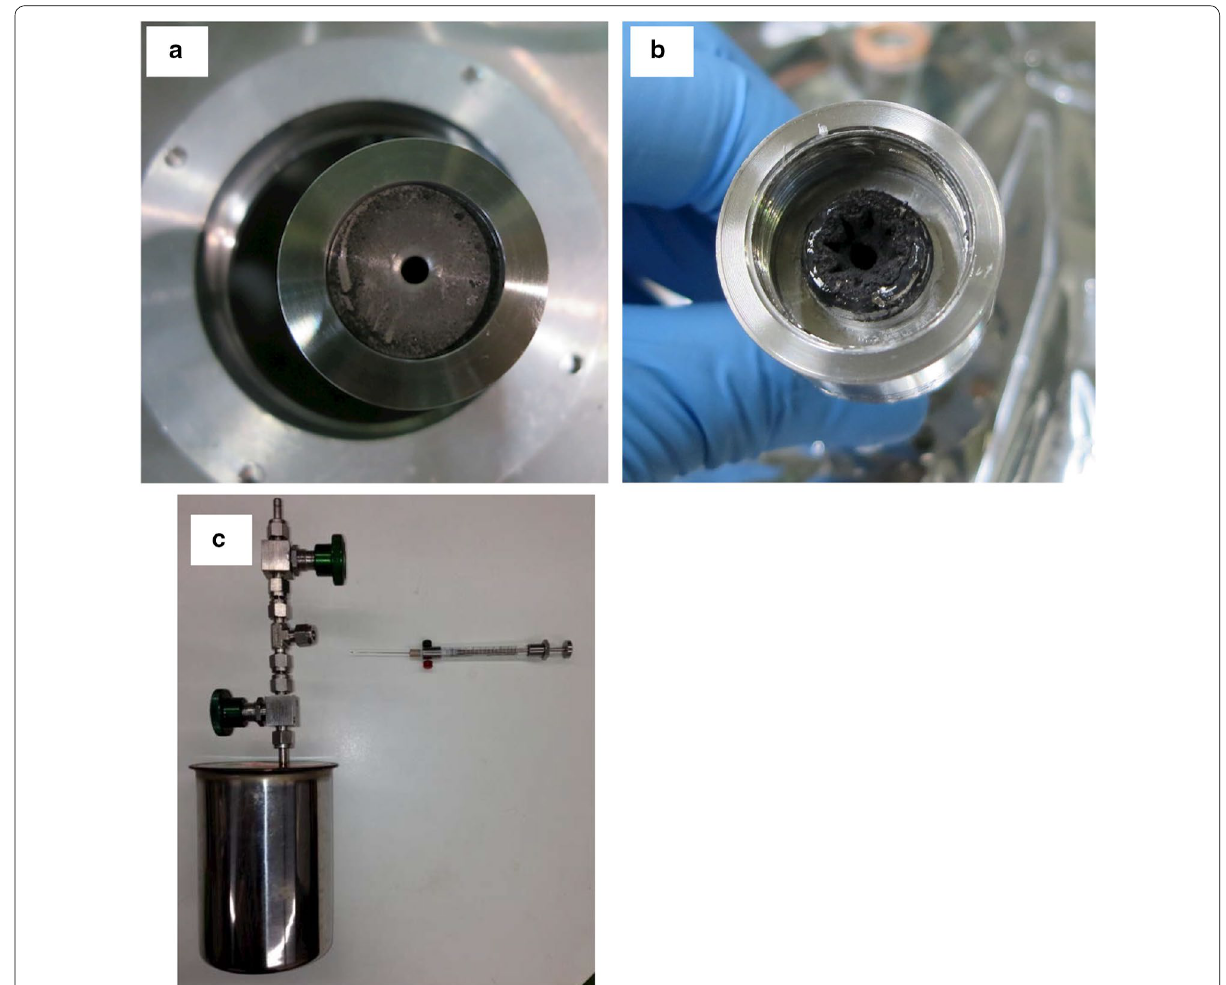
Fig. 4 a , b Carbonaceous product after the explosion simulation. c Volatile gas sample